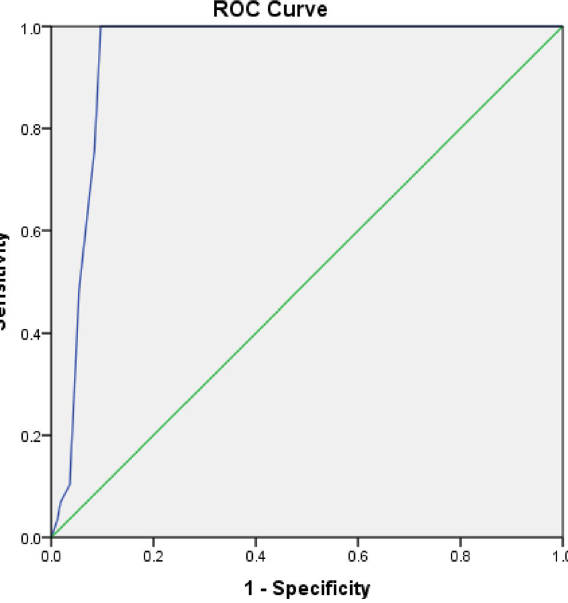
Figure 1. Receiver operating characteristic (ROC) curve of O 2 saturation for identifying severe/critical COVID-19 infection.